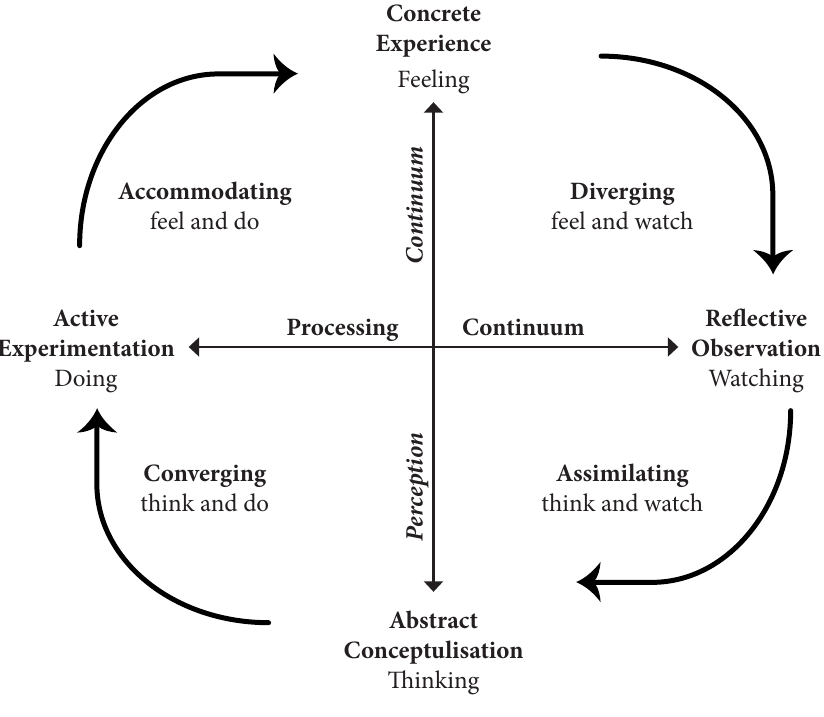
Figure 3: Kolb's experiential learning